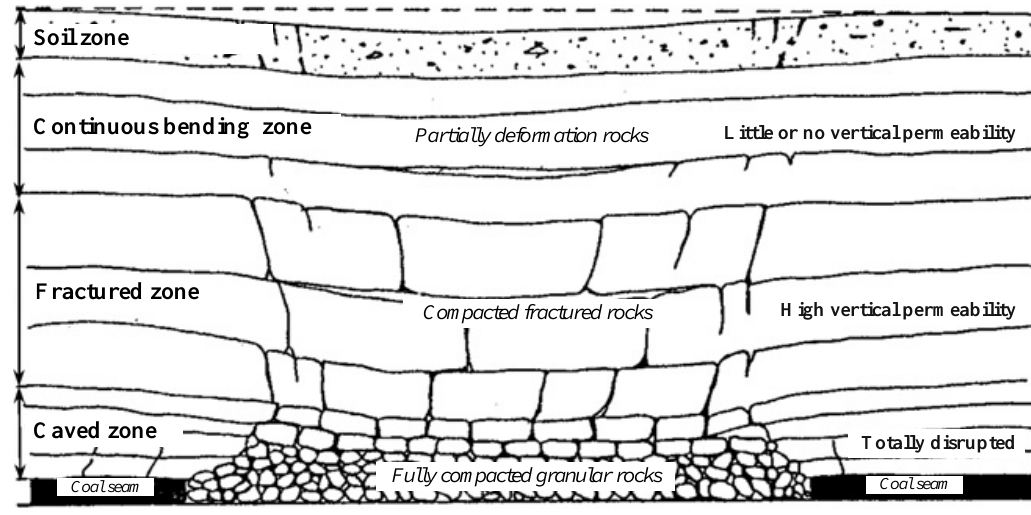
Figure 3. Four zones of strata deformation in longwall mining [24].